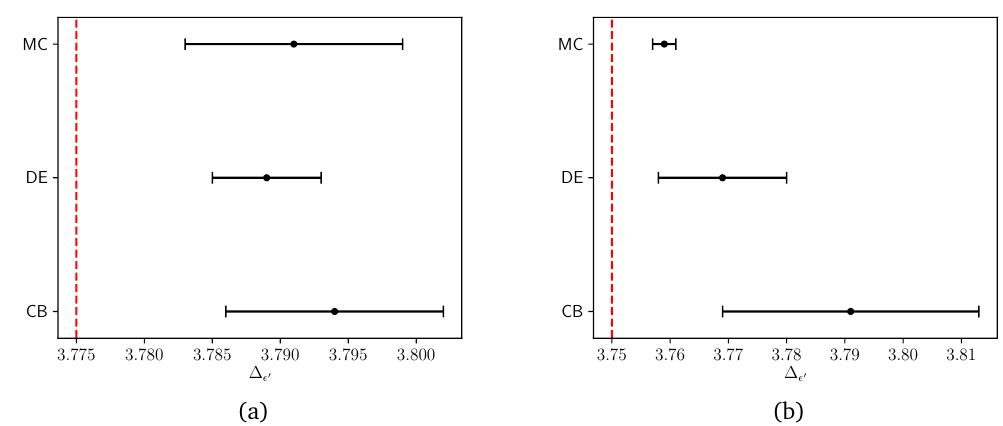
Figure 9: Comparison of the ∆ ε (cid:48) estimates for the O(2) (left) and the O(3) (right) model from conformal bootstrap (CB), derivative expansion (DE) [ 58 ] and Monte Carlo (MC) methods. The CB estimates are from [ 52 ] and [ 71 ] for N = 2 and N = 3 respectively. The MC results are taken from refs. [ 72 ] and [ 54 ] . The dashed red lines mark the values we chose for the gap in the bulk spectrum above ∆ ε